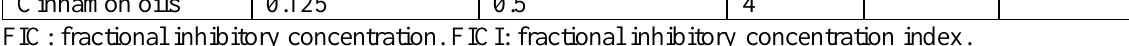
Table 3: FIC and FICI values for the combination of Tea tree and Cinnamon oils. Combination MIC alone MIC combined FIC FICI Remark Tea tree 0.25 0.0625 0.25 4.25 Antagonism Cinnamon oils 0.125 0.5 4 FIC: fractional inhibitory concentration. FICI: fractional inhibitory concentration